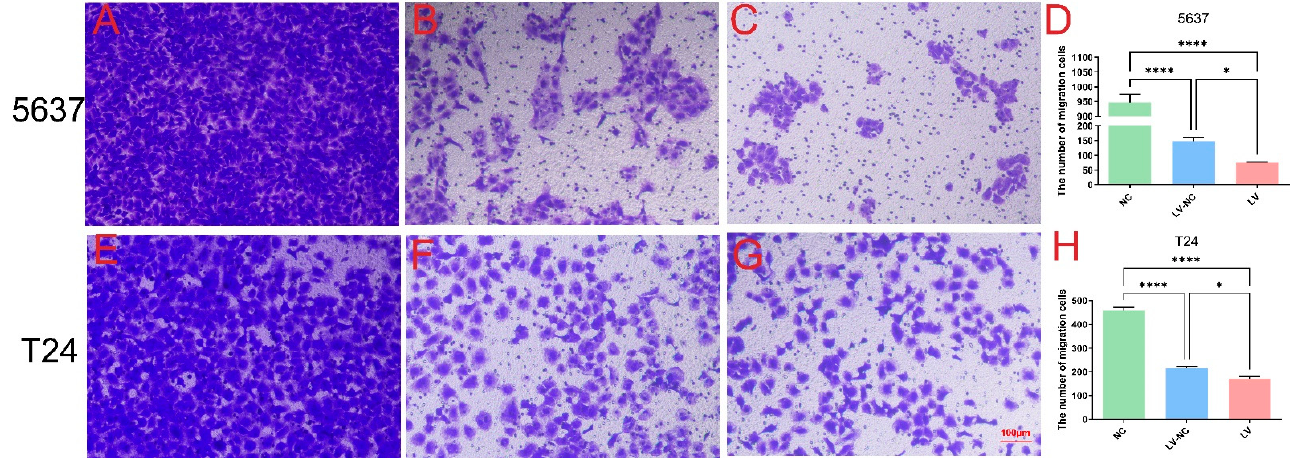
Figure 4. The Transwell migration assay of three groups (transfection group, LV; negative control group, LV-NC; blank group, NC) in 5637 cells ( A – D ) and T24 cells ( E – H ). * indicates p -value < 0.05. **** indicates p -value < 0.0001.